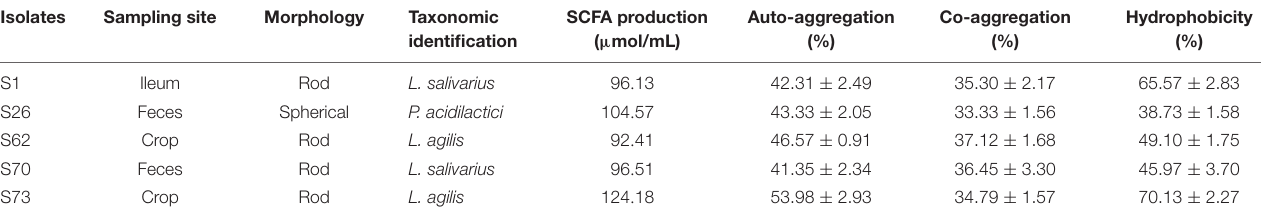
TABLE 3 | Characterization of lactic acid bacteria candidates.